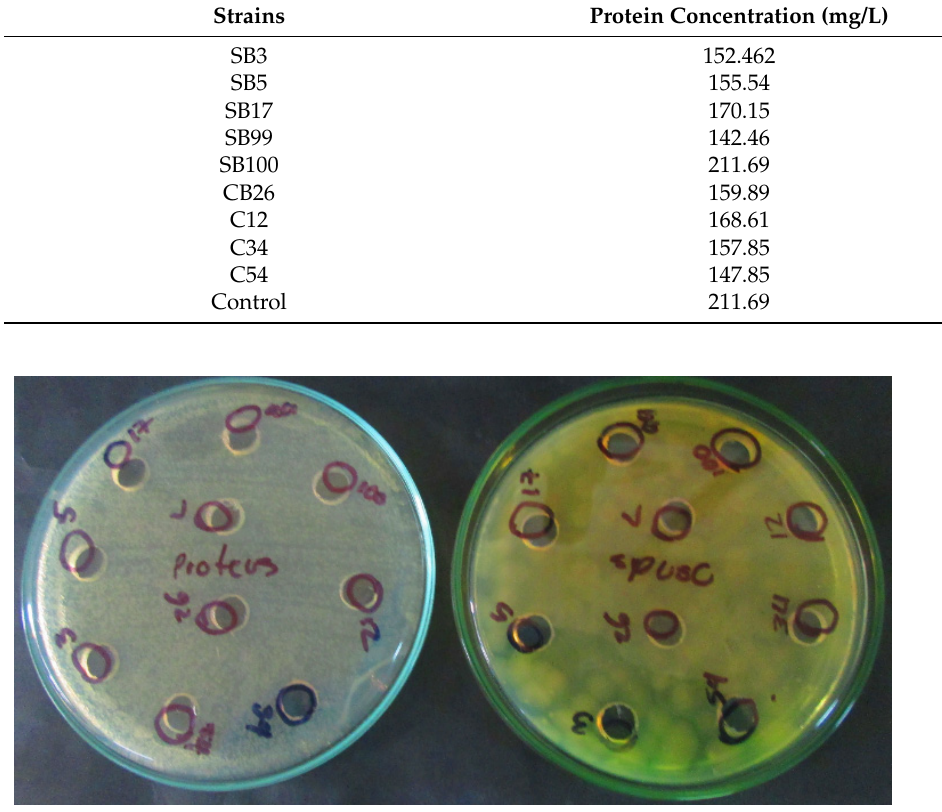
Figure 4. Results for isolate supernatants treated with ammonium sulfate.